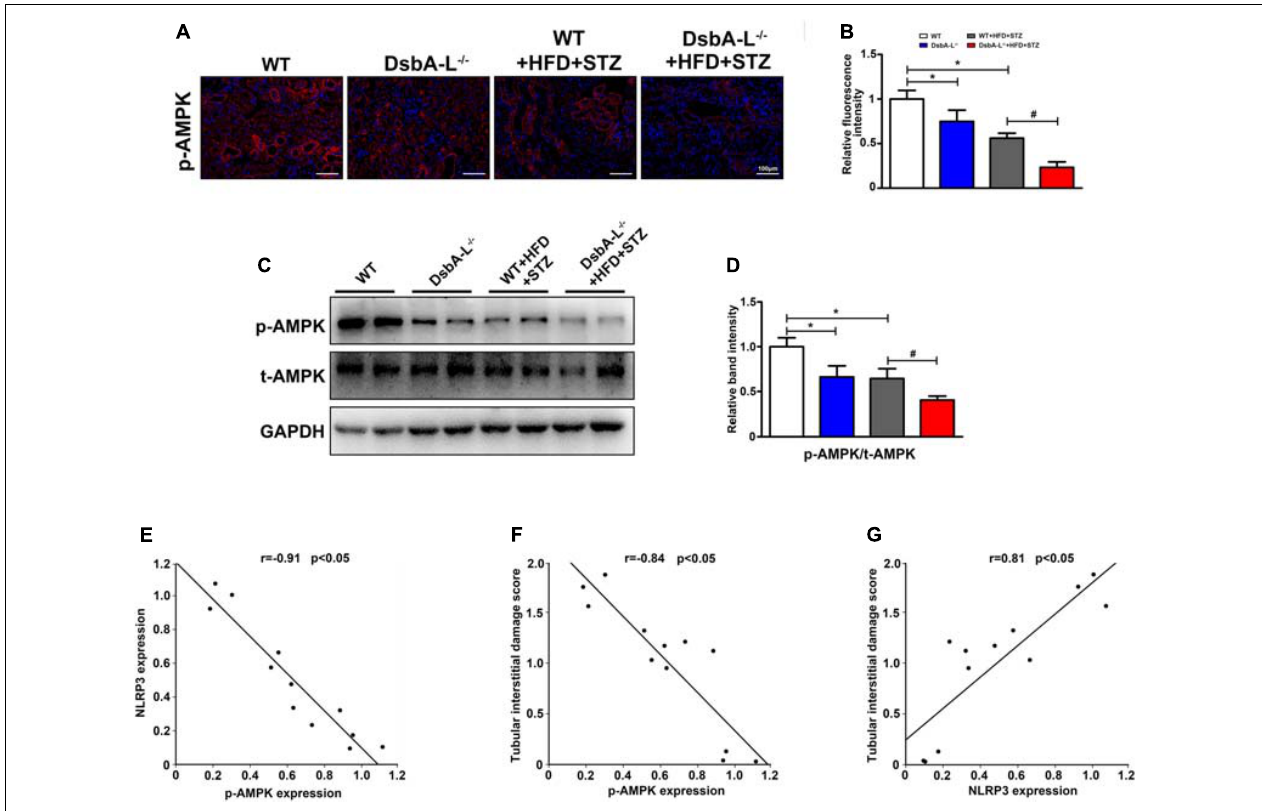
FIGURE 3 | Inhibited AMPK phosphorylation in the kidneys of diabetic DsbA-L-deficient mice. (A,B) IHC staining reveals decreased expression of NLRP3 in the kidneys of diabetic and DsbA-L − / − mice, which was further reduced in diabetic DsbA-L − / − mice. (C,D) Western blot analysis further confirms the decreased AMPK phosphorylation in the kidneys of diabetic DsbA-L − / − mice. Correlation analysis between AMPK phosphorylation and NLRP3, r = –0.91, p < 0.05 (E) , AMPK phosphorylation and tubular damage, r = –0.84, p < 0.05 (F) , and NLRP3 expression and tubular damage, r = 0.81, p < 0.05 (G) . The correlation of the two numerical variables was tested by Pearson’s analysis. The values are the mean ± SD. n = 3/group. * p < 0.05 compared with the control group; # p < 0.05 compared with the diabetic